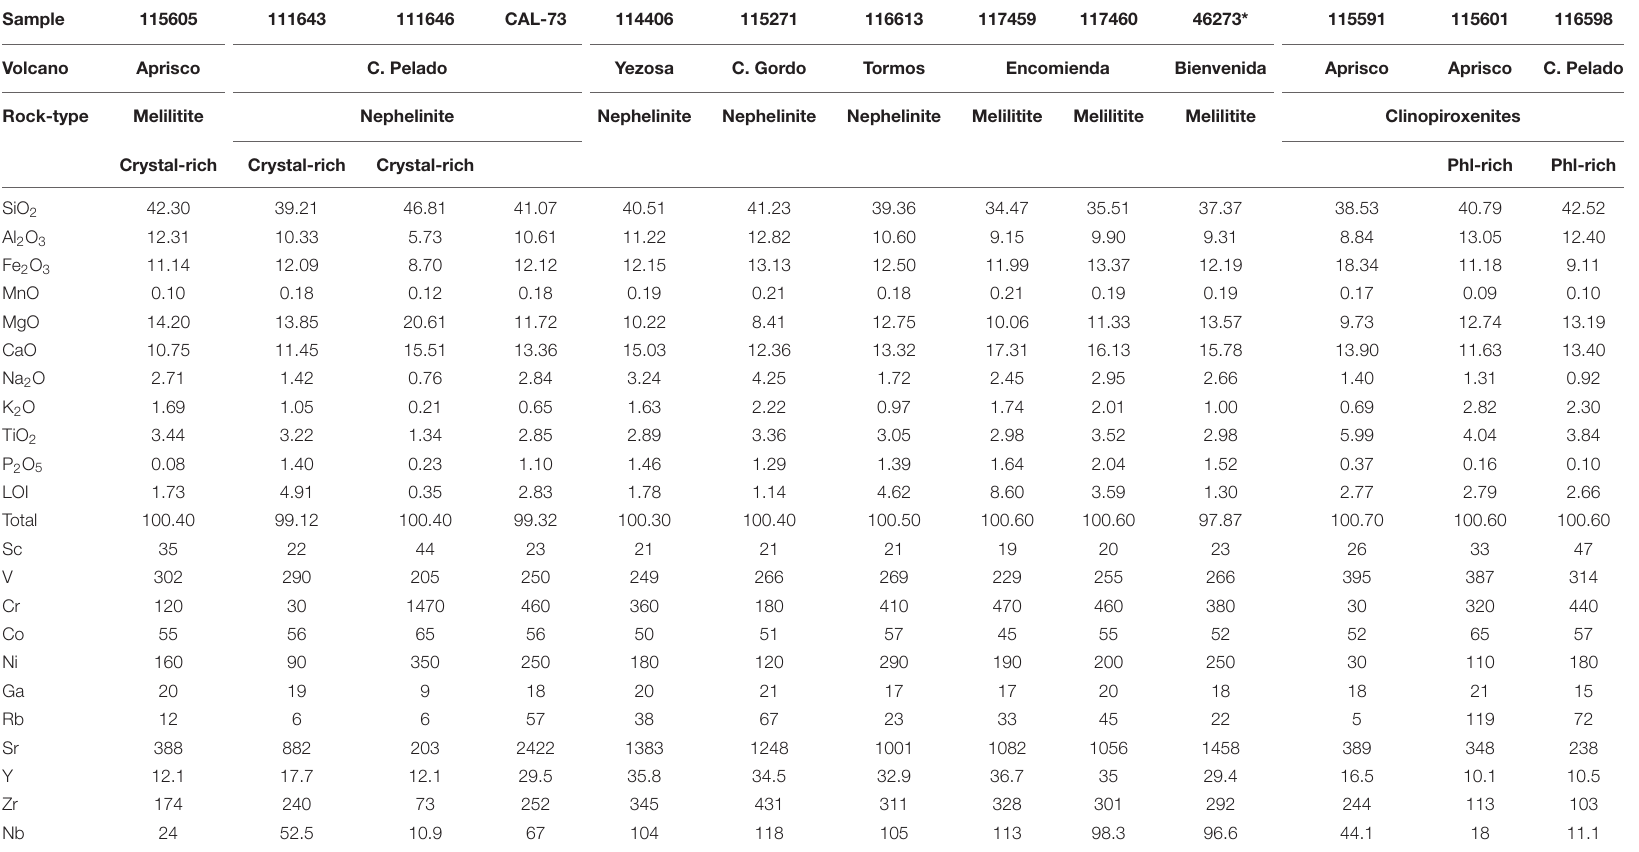
TABLE 1 | Whole-rock major (wt%) and trace element (ppm) composition of the Calatrava Volcanic Field (CVF) rocks. Sample